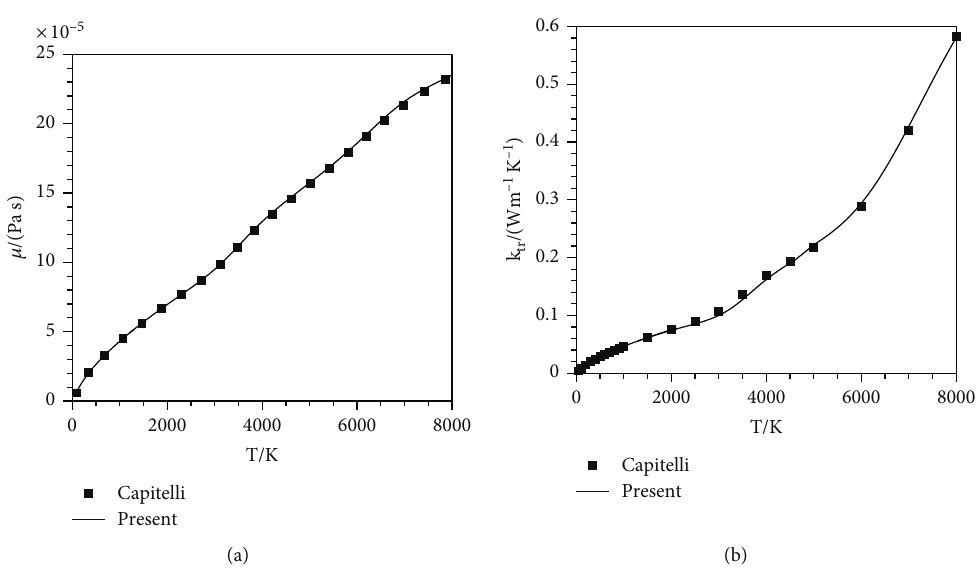
Figure 1: Comparison of the present results with Capitelli et al. [18]. (a) Viscosity; (b) translational thermal